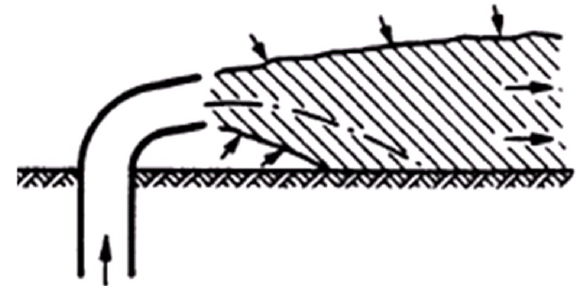
Fig. 6. Example of Coanda attachment conditions for submerged jets discharging near boundaries (after (Jirka et al.,